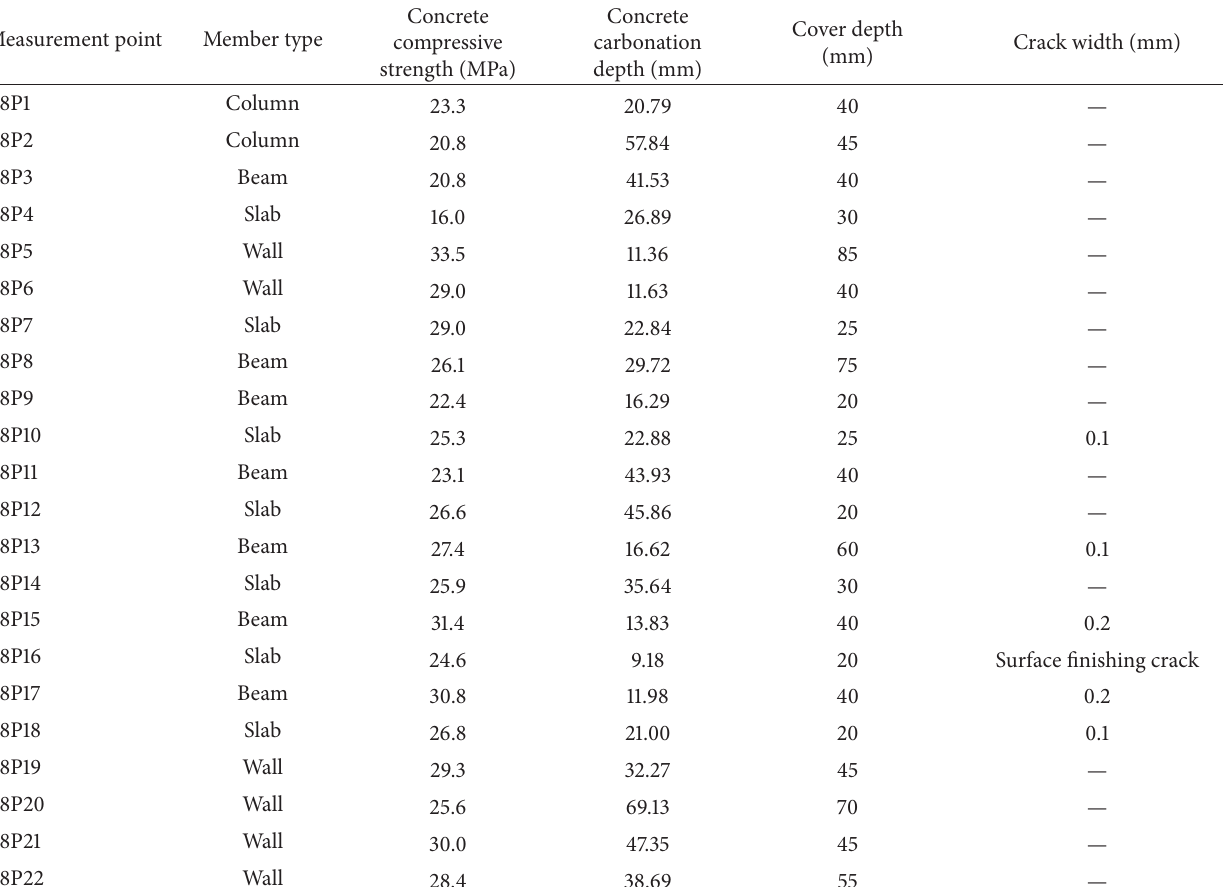
Table 10: Field investigation data (Building 8, construction completion year: